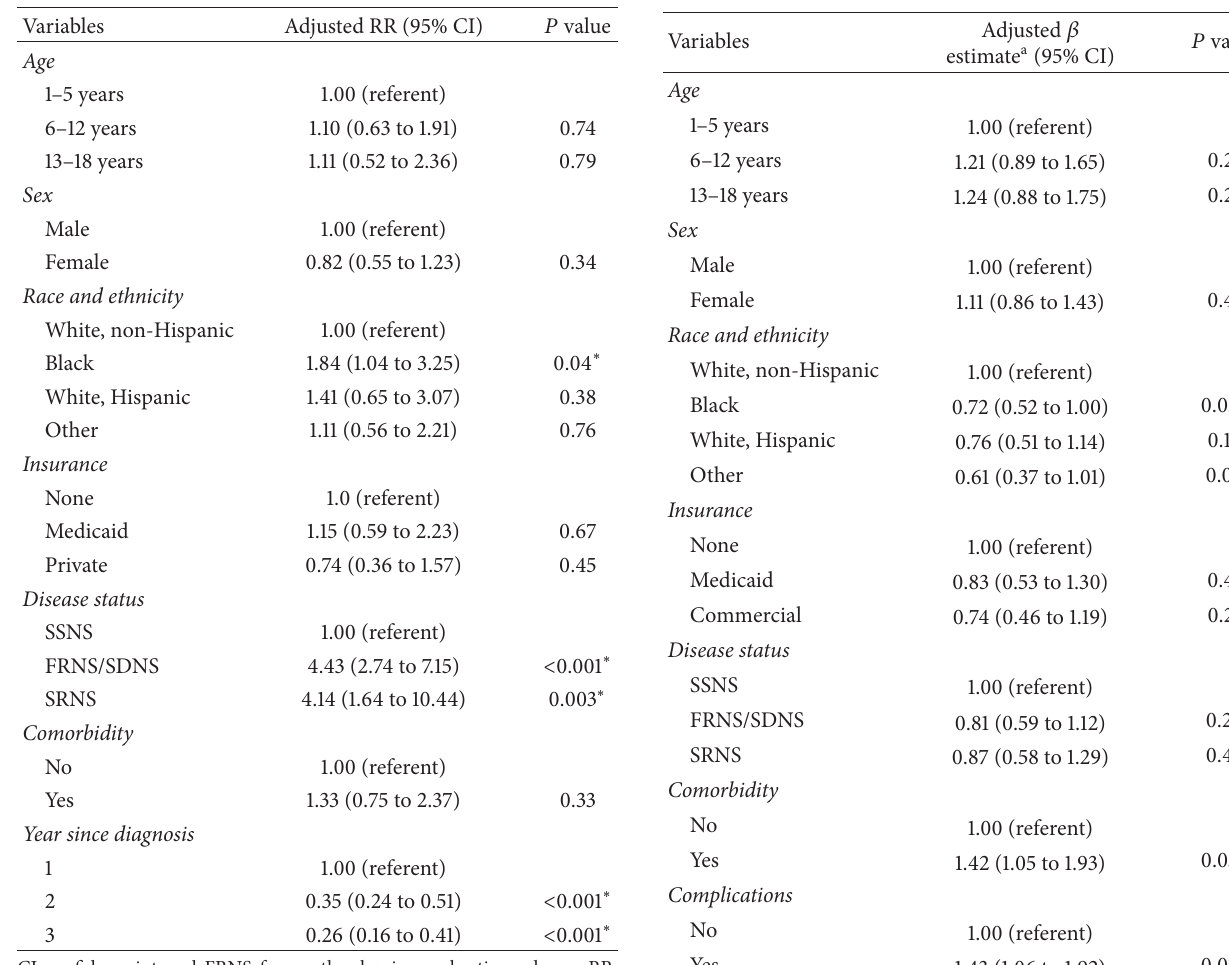
Table 3: Association between patient characteristics and hospital- ization rate.